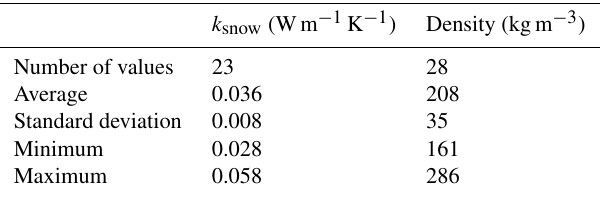
Table 1. Variations in values of thermal conductivity, k snow , and density of the basal depth hoar layer (lowest 5cm) based on mea- surements in 10 pits on herb